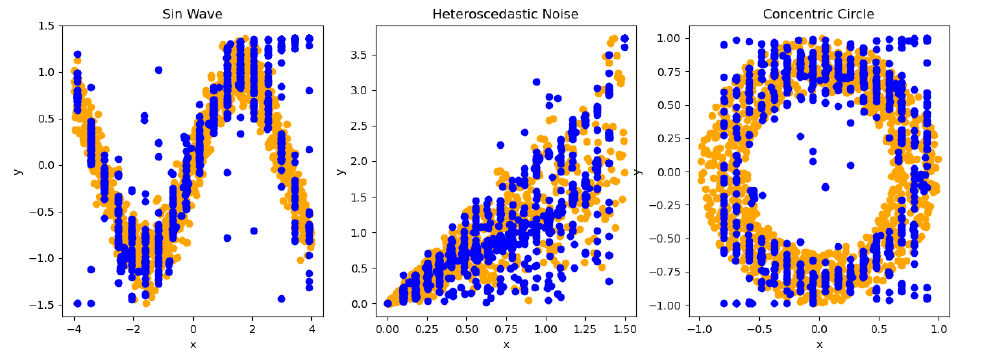
Figure 12. The sinusoidal wave dataset, heteroscedastic noise dataset and annulus dataset predicted at a given values of the x coordinate using the WGAN prediction method. Prediction displays potential responses at the given x